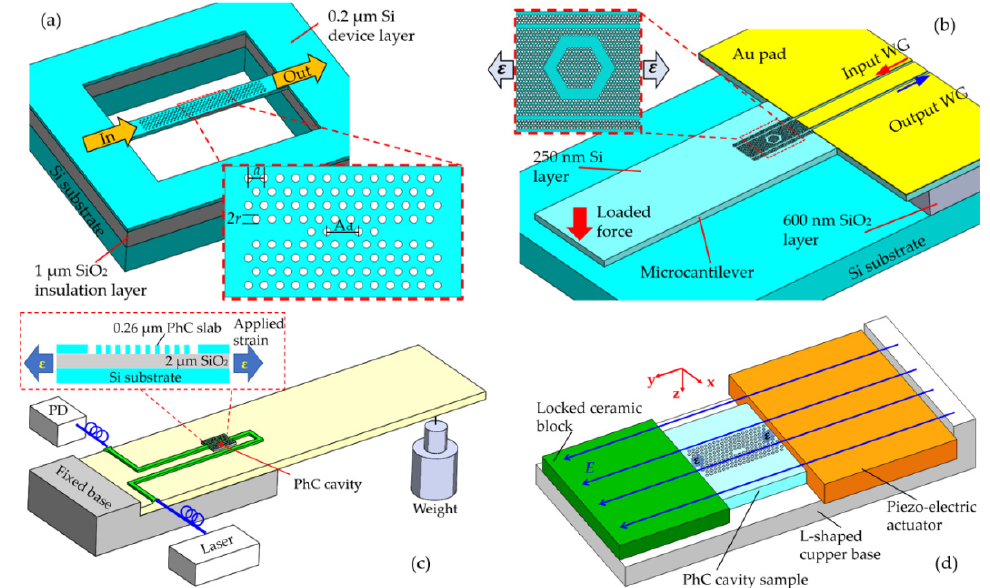
Figure 5. ( a ) Schematic of the pressure detection system based on PhC cavity (inset: layout of PhC using a hexagonal array of holes with the lattice constants a , A d and r are the distance between the center two holes and radius of hole) [97]; ( b ) 3D illustration of 2D PhC slab strain sensors using PhC resonator structure (inset: deformed single ring PhC cavity driven by stress) [73]; ( c ) schematic of PhC cavity for strain sensing (inset: sectional view of strain applied on PhC) [98,99]; ( d ) schematic of electric field sensor with strain tuning of defect with PhC cavity [15].